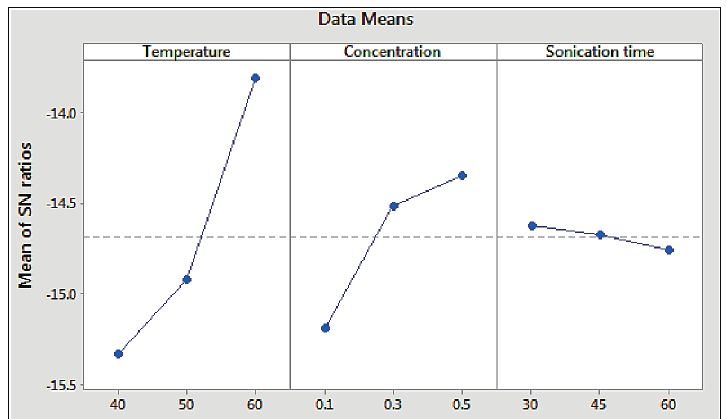
Figure 7: SN ratio effect for thermal conductivity (ball-milled